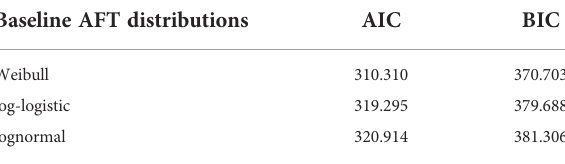
TABLE 5 Comparison of AFT models using AIC and BIC for a given